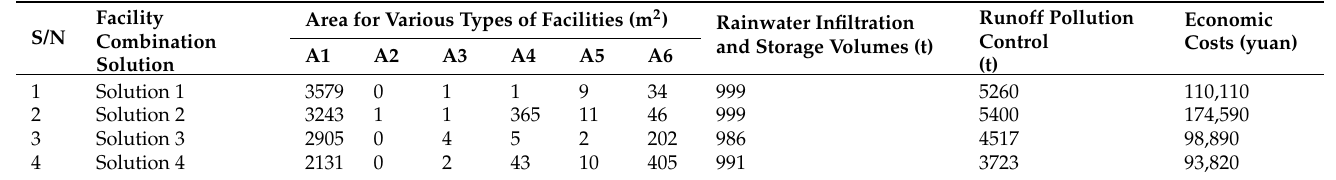
Figure 11. Optimal parameters for all objectives. Table 8. The value of the model variable when the comprehensive objective is optimal.